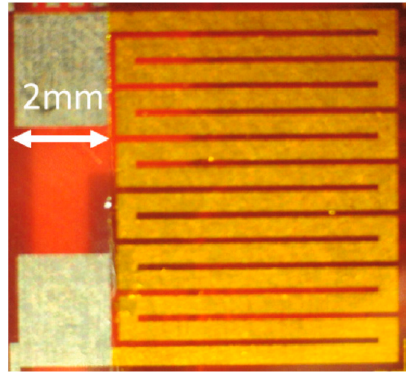
Figure 7. Photograph of the polyimide heater.